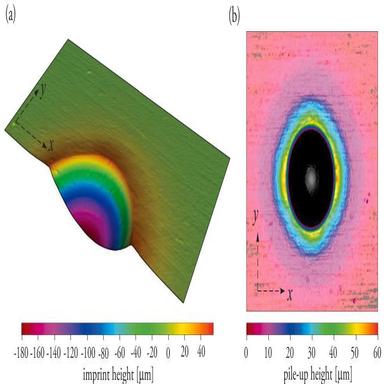
The 3D scan of the residual imprint geometry: (a) Contour plot of a typical pile-up height, with the zero height (in green) set to the reference plane and the maximum height set to red. (b) A clear indication of anisotropic behaviour can be seen in the plot with the maximum height at rolling direction. The minimum height is visible at approx. diagonal direction. The rolling marks at the undeformed sheet metal surface are evident in the vicinity of the indented shape.